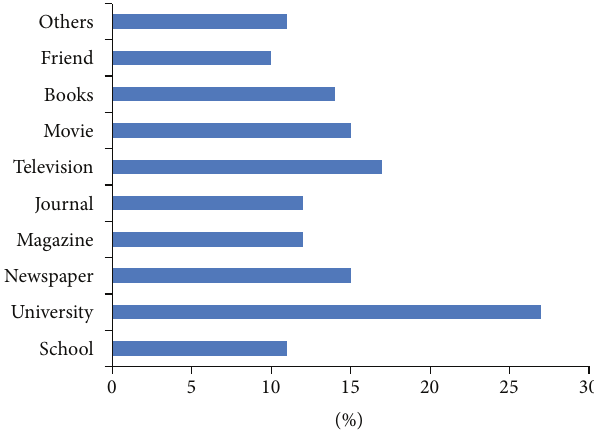
Figure 1: How did you hear about